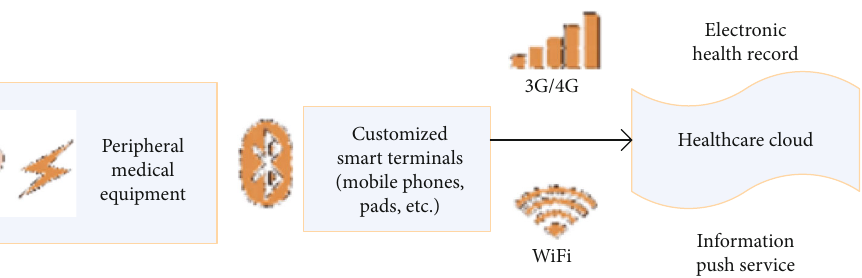
Figure 4: System composition.